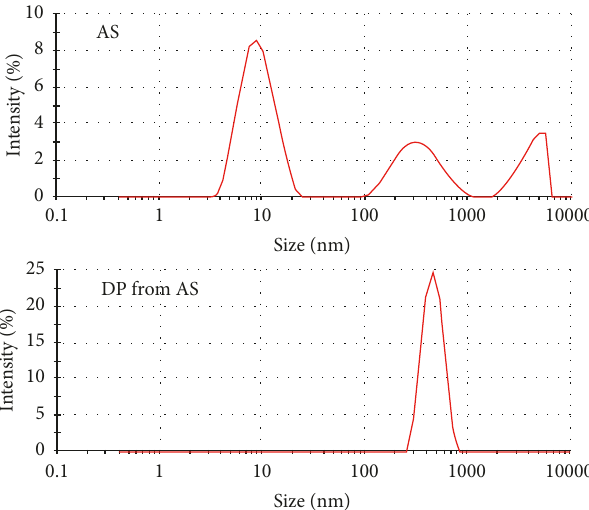
Figure 3: Particle size distribution in albumin solution (AS, 20 mg/ml) and in dissolved Ca phosphate precipitate of AS (DP from